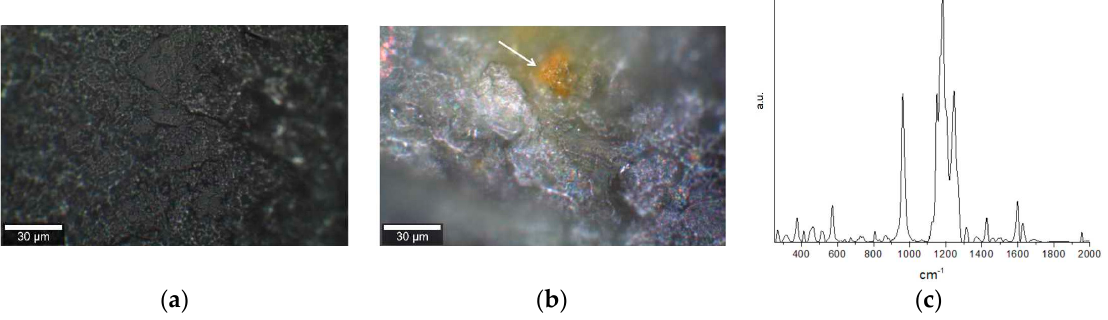
Figure 6. Nail surface after Photodynamic therapy (PDT) treatment with cream ( a ) and gel ( b ). A piece